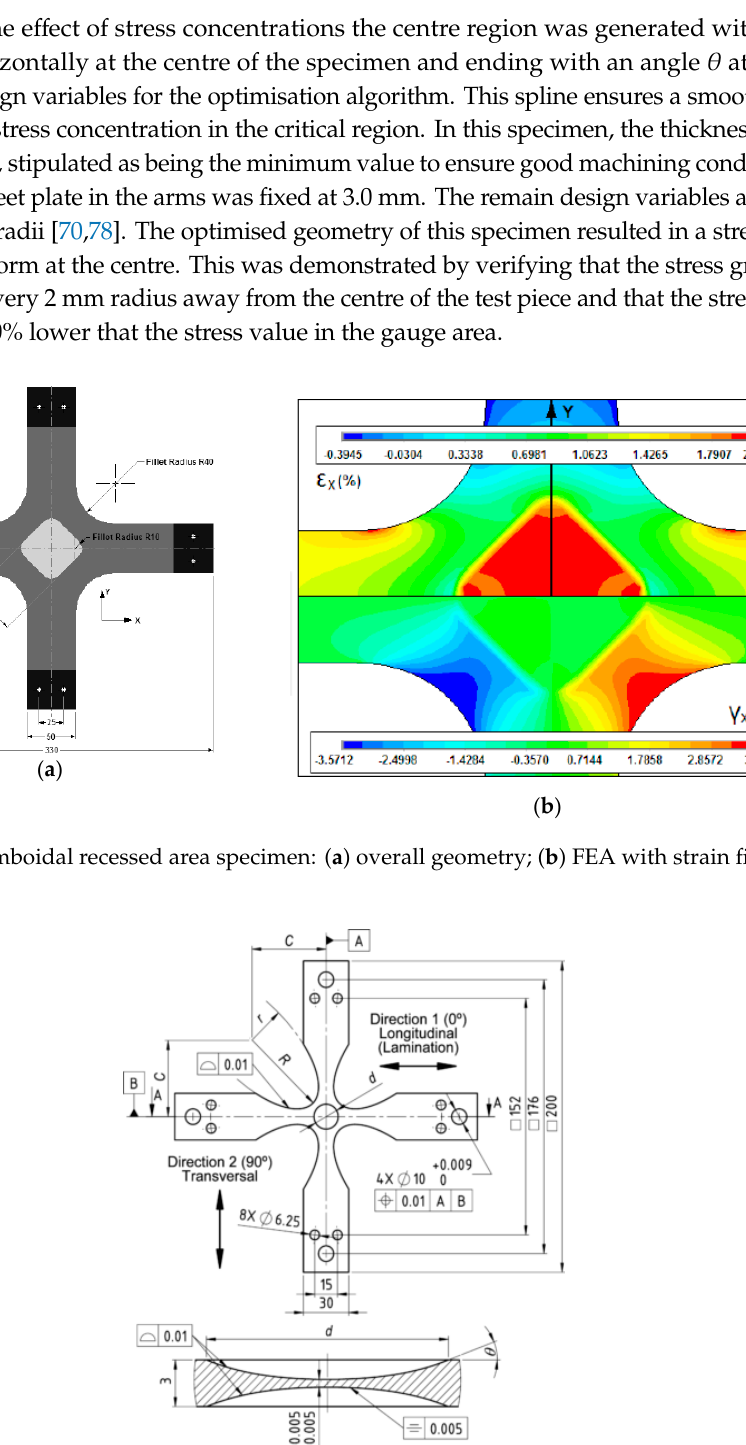
Figure 10. Typical biaxial cruciform specimens with: ( a ) slits [81]; ( b ) elliptical notched corners [70]; ( c ) circular-notched corners and reduced thickness at the centre [70].